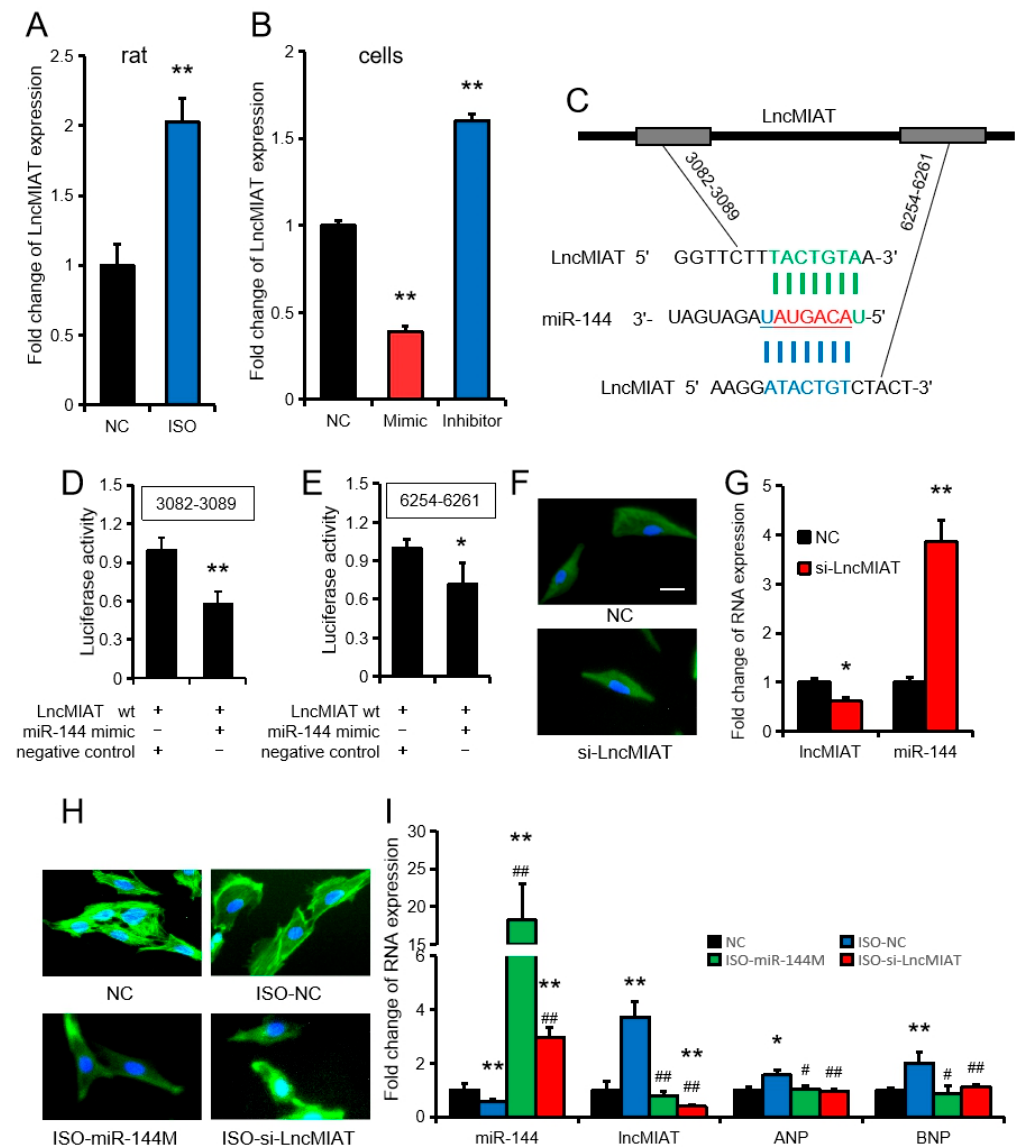
Figure 7. Long non-coding RNA myocardial infarction associated transcript (LncMIAT) acts as an miR-144 sponge and is involved in cardiac hypertrophy. ( A , B ) The expression of LncMIAT in rat myocardial primary cells after treatment with 10 µ M isoprenaline (ISO) ( A ) or transfection with the miR-144 mimic, inhibitor, or negative control ( B ). ( C ) Binding site of miR-144 and LncMIAT. ( D , E ) The fluorescence intensity of the dual luciferase reporter assay. ( F ) Rat myocardial primary cells were transfected for 24 h, as indicated above. Cellular F-actin and the nuclei of the cell in each group were stained with FITC-phalloidin and DAPI. The bars of the charts indicate 25 µ m. ( B , D – F ) are all carried out under normal conditions, without ISO treatment. ( G ) The expression of LncMIAT and miR-144 in rat myocardial primary cells after transfection with siRNA (si-LncMIAT) or the negative control (NC). ( H ) Rat myocardial primary cells were transfected for 24 h, as indicated above. Cellular F-actin and the nuclei of the cell in each group were stained with FITC-phalloidin and DAPI. The bars of the charts indicate 25 µ m. ( I ) Fold change of RNA expression in rat myocardial primary cells after transfection with “negative control (NC)”, “negative control + ISO (ISO-NC)”, “miR-144 Mimic + ISO (ISO-miR-144M)”, and “si-LncMIAT + ISO (ISO-si-LncMIAT)”. All results are presented as the mean ± SEM. n = 3. * p < 0.05, ** p < 0.01, when compared to the negative control (NC). # p < 0.05, ## p < 0.01 when compared to the ISO-treated